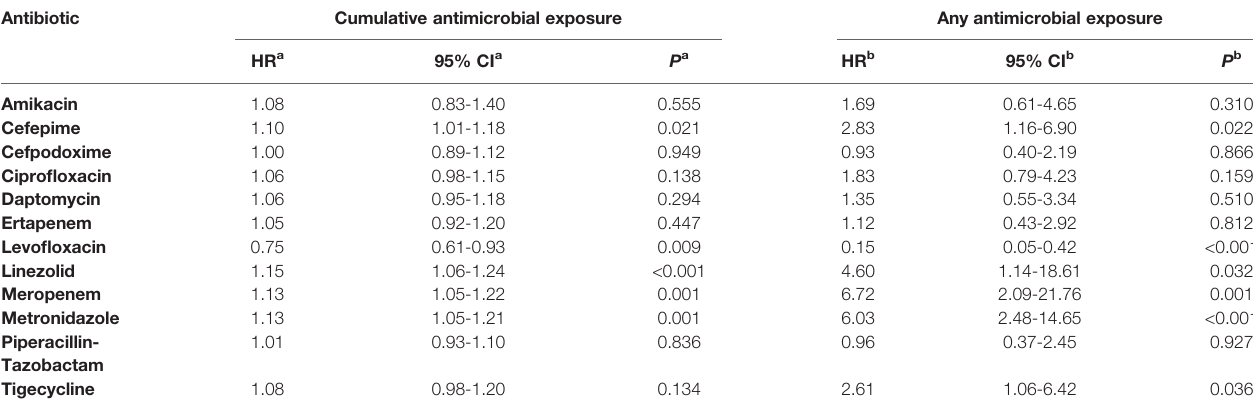
TABLE 1 | Time-varying analysis of antibiotic exposure during the risk period for patients who do and do not exhibit oral-stool microbial coalescence. Antibiotic Cumulative antimicrobial exposure Any antimicrobial exposure HR